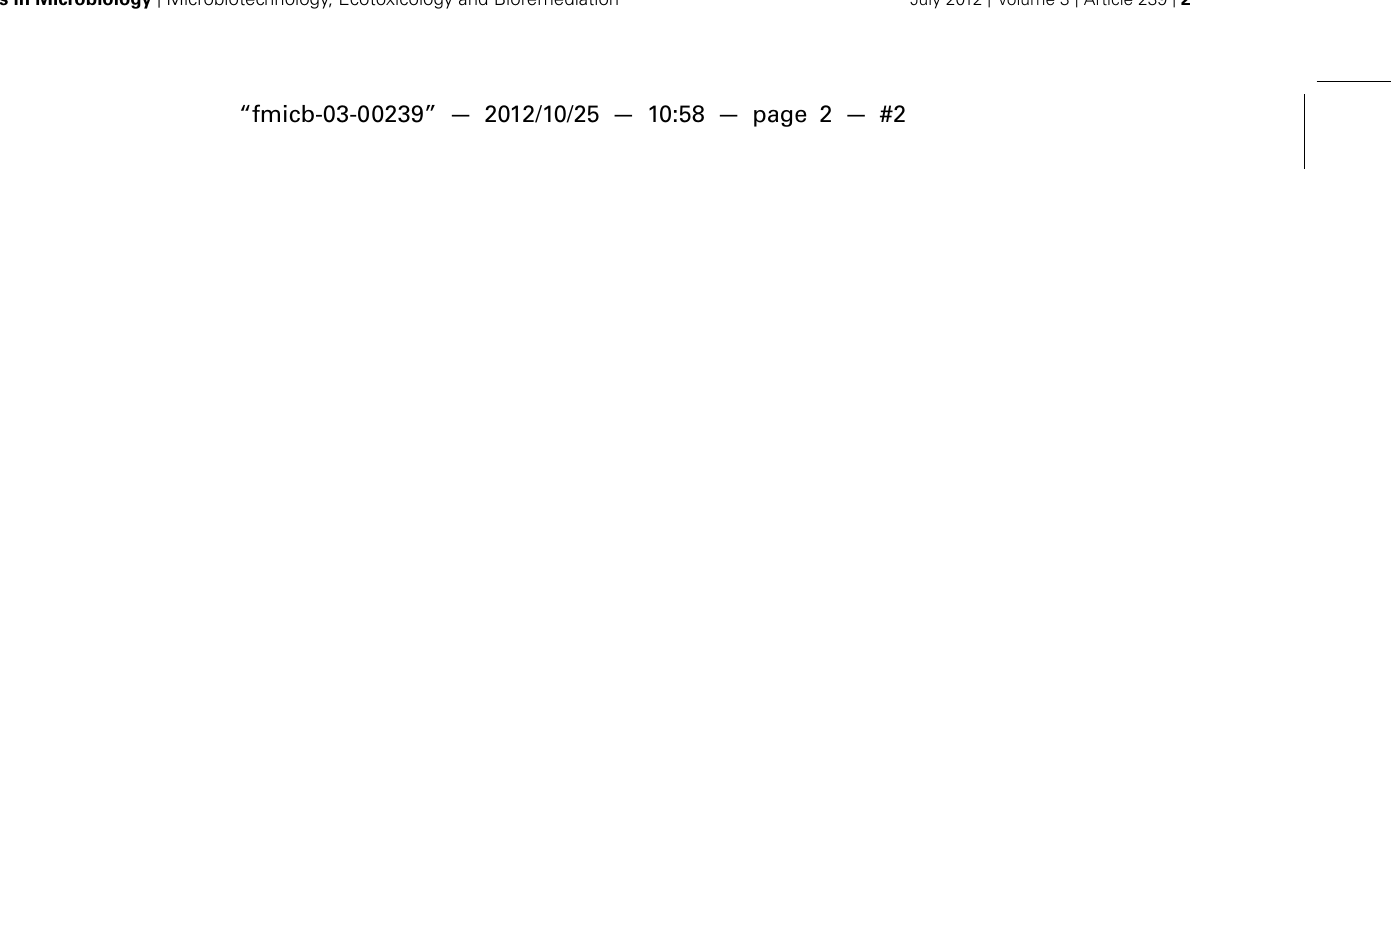
FIGURE 1 | Structures of (A) a model humic acid (adapted from Stevenson, 1994) and (B) surface functional groups on activated carbon, which are